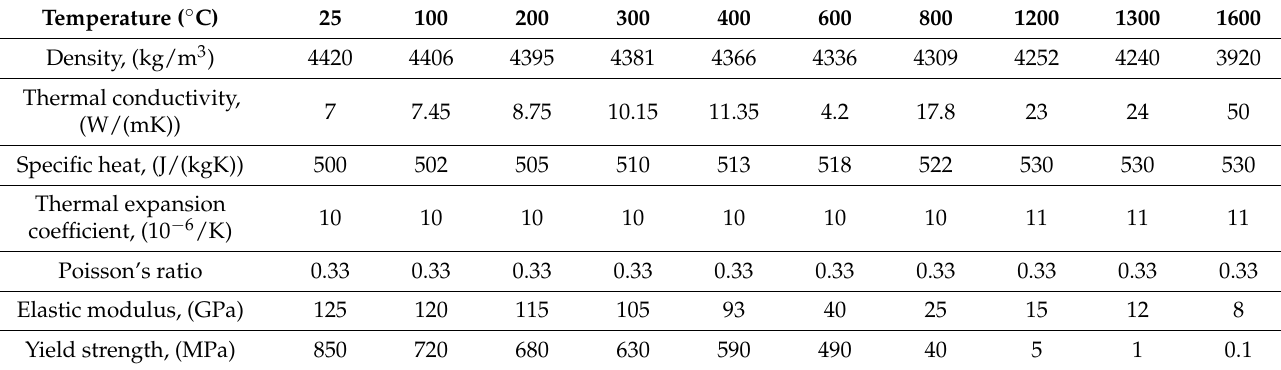
Table 6. Thermo-mechanical properties of the